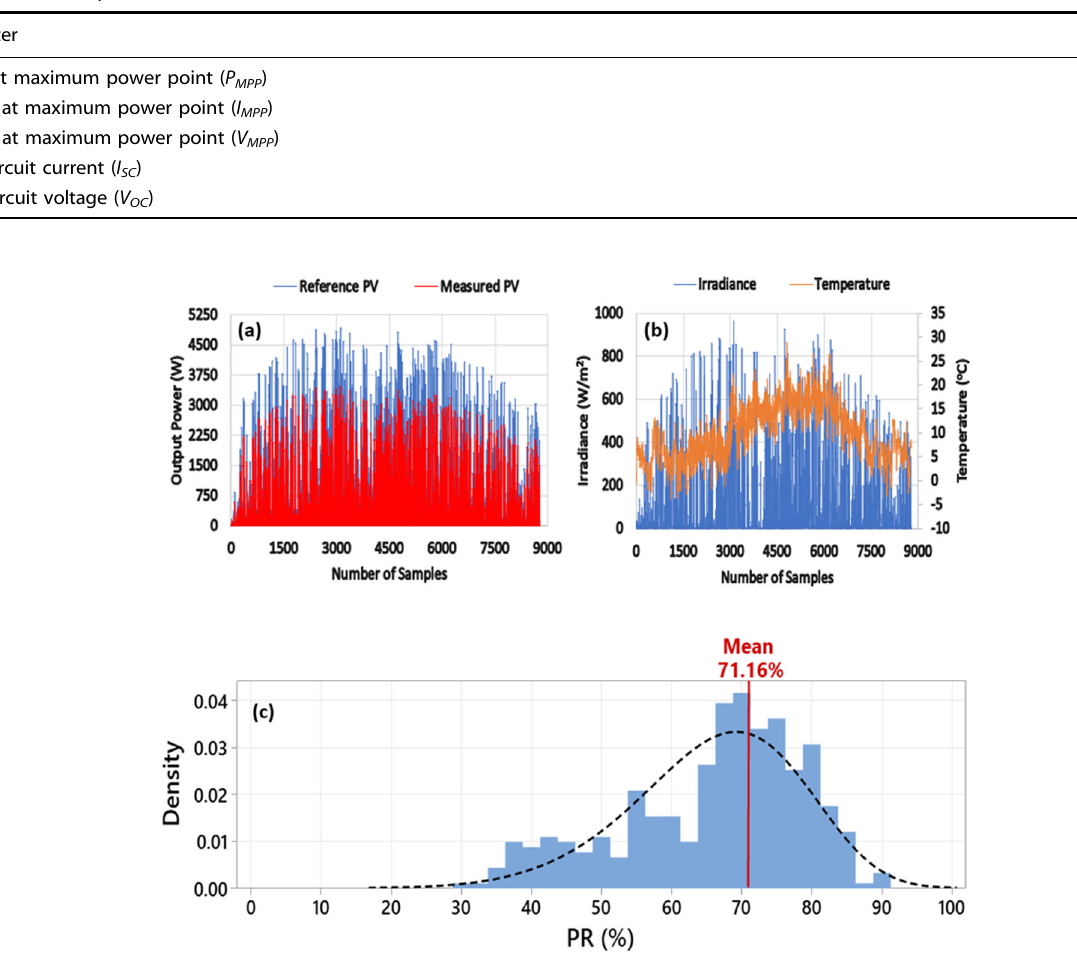
Fig. 10 Output measurements of the PV modules while operating in the fi eld. a Measured PV output power (after PID test is completed) versus reference PV cell output power. b Solar irradiance and PV cell temperature. c PR ratio analysis.